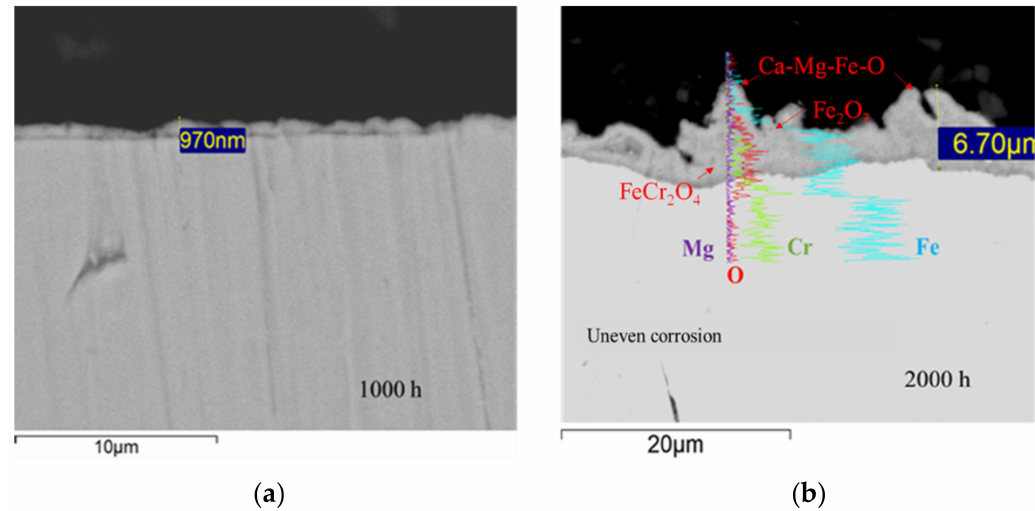
Figure 11. Microstructural characterization of the VM12 cross-section tested in “Solar Salt” in accelerated flow conditions (0.2 m/s) at 500 ◦ C; ( a ) after 1000 h, ( b ) after 2000 h.